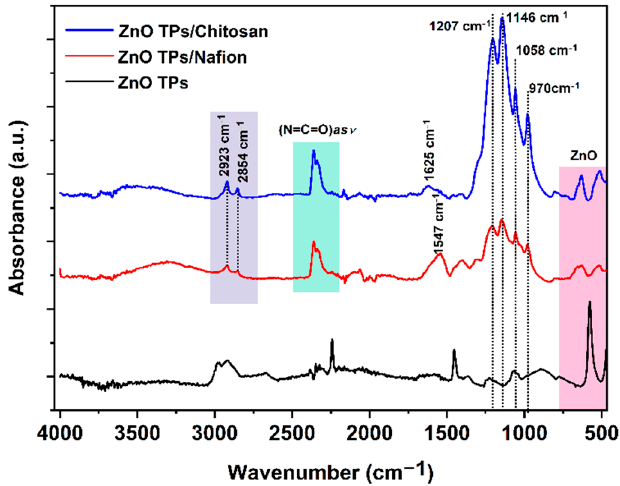
Figure 4. FTIR spectra of ZnO TPs, ZnO TPs/Nafion, and ZnO TPs/chitosan samples.